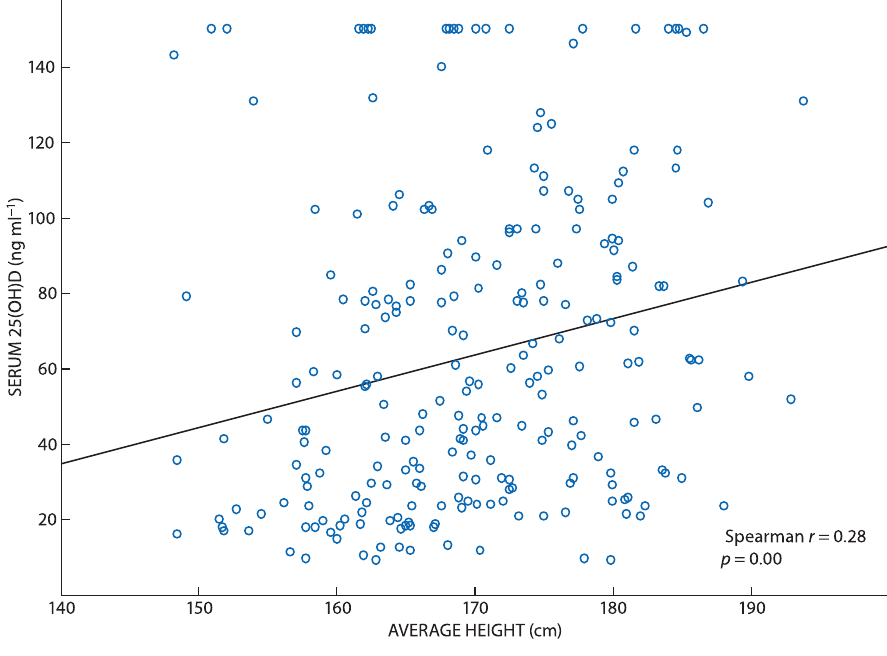
Figure 2: Serum 25(OH)D and